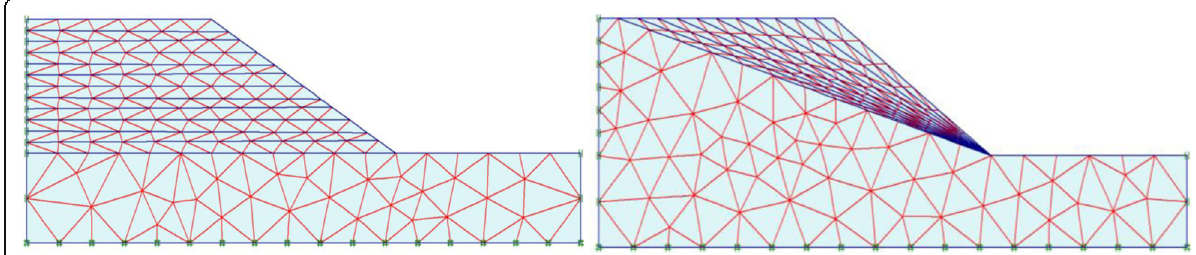
Fig. 9 Mesh arrangement of height model and slope model